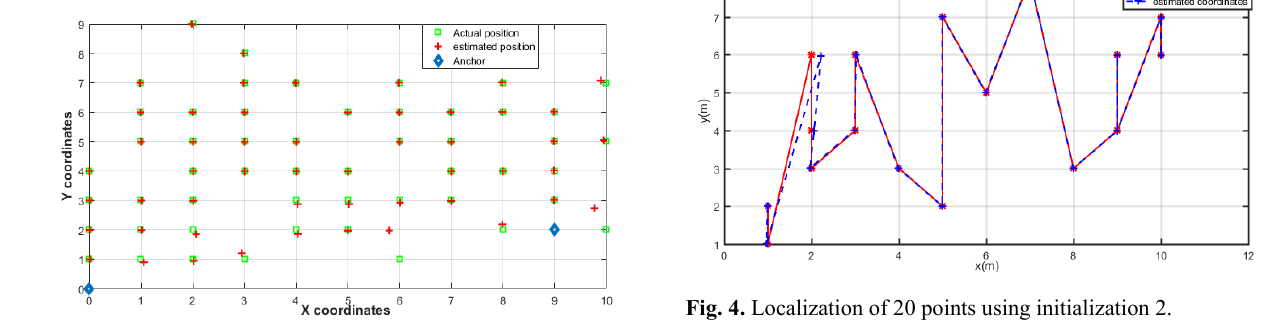
Fig. 2. Localization of 55 points using gradient descent.